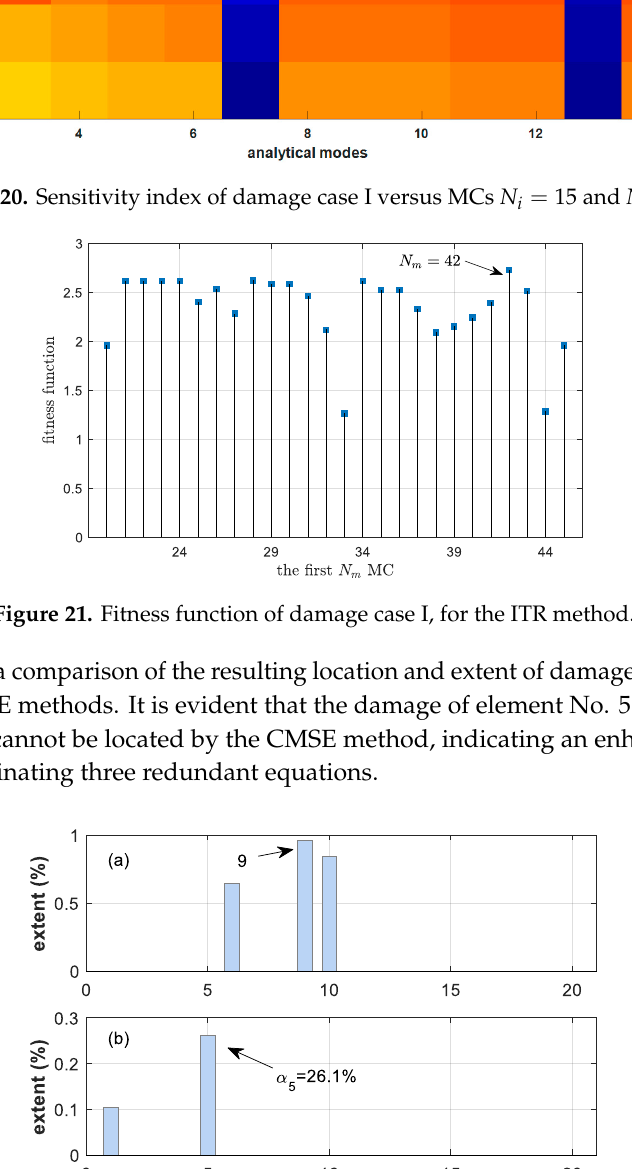
Figure 22. Damage identification results of damage case I, with an iterative Tikhonov solution: ( a ) CMSE method; ( b ) RCMSE method.